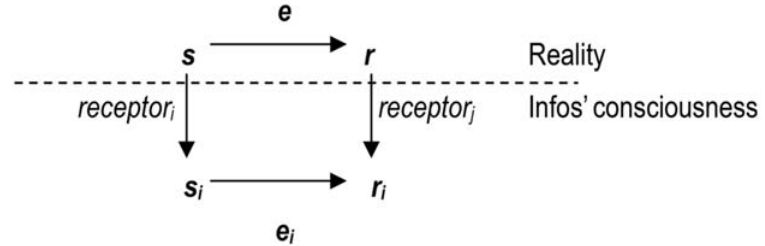
Figure 1. Diagram of reflections